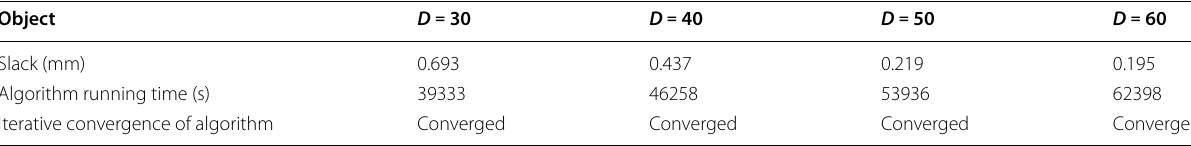
Table 2 Comparison of related objects of automatic optimization algorithm under different absolute range values of variables